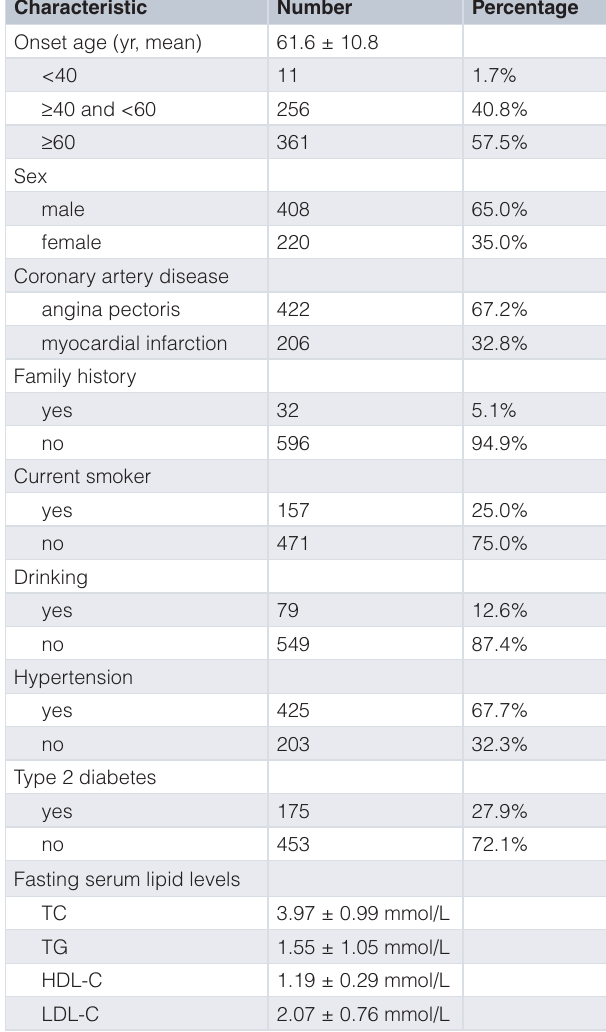
Table 1. Characteristics of the 628 patients with coronary artery disease.